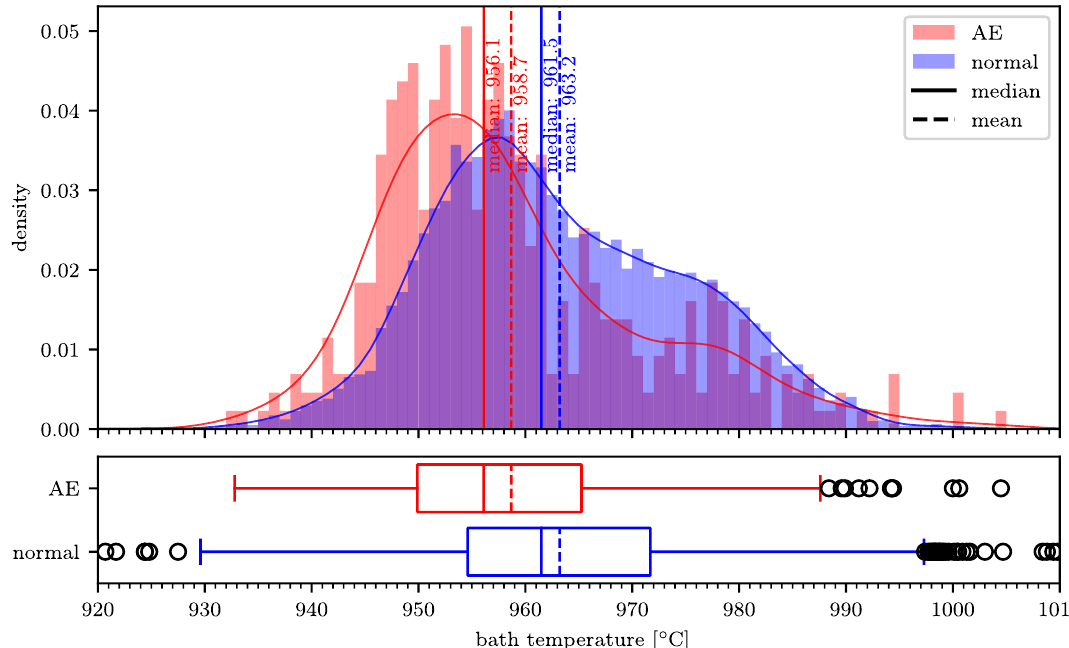
Figure 3. Distribution of bath temperature in training